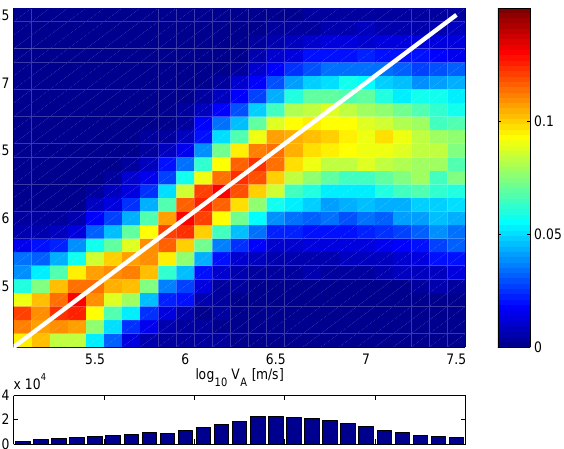
Fig. 9. The calculated mean Alfv´en velocity [log m/s] (blue) and